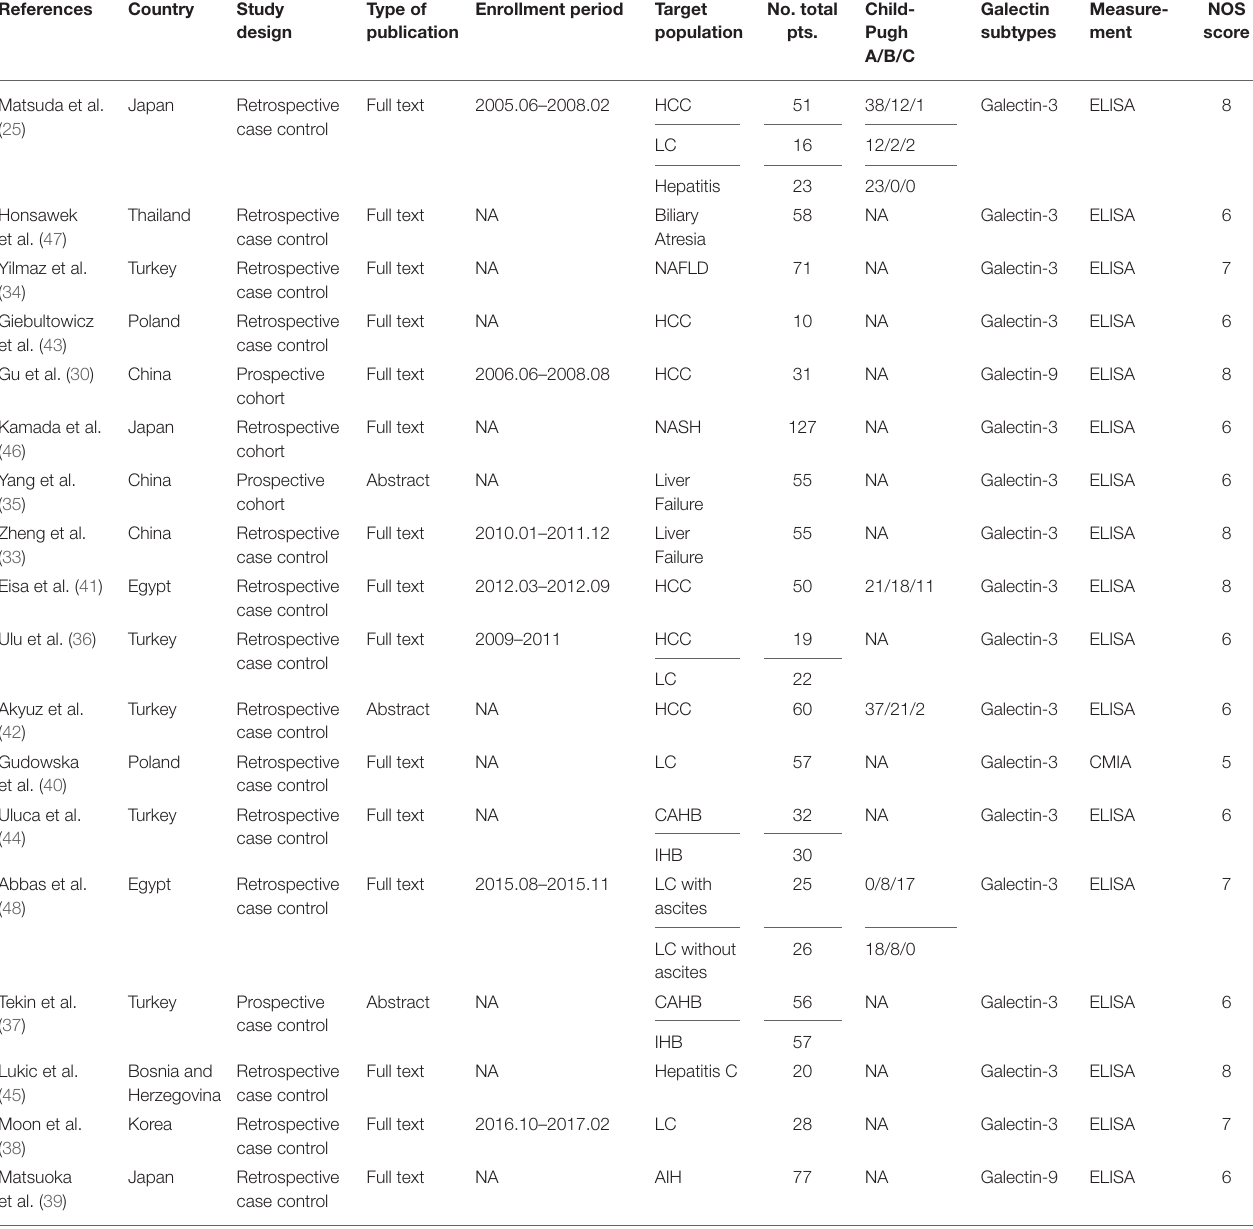
TABLE 3 | Characteristics of the included studies regarding the galectins with the risk of different liver